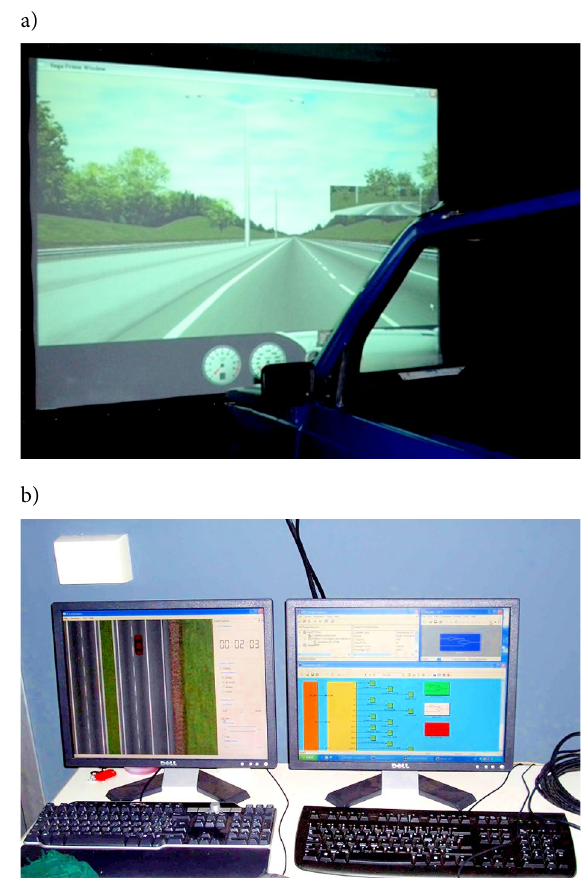
Fig. 3. Instrumented cockpit (a) and simulator control desk (b)